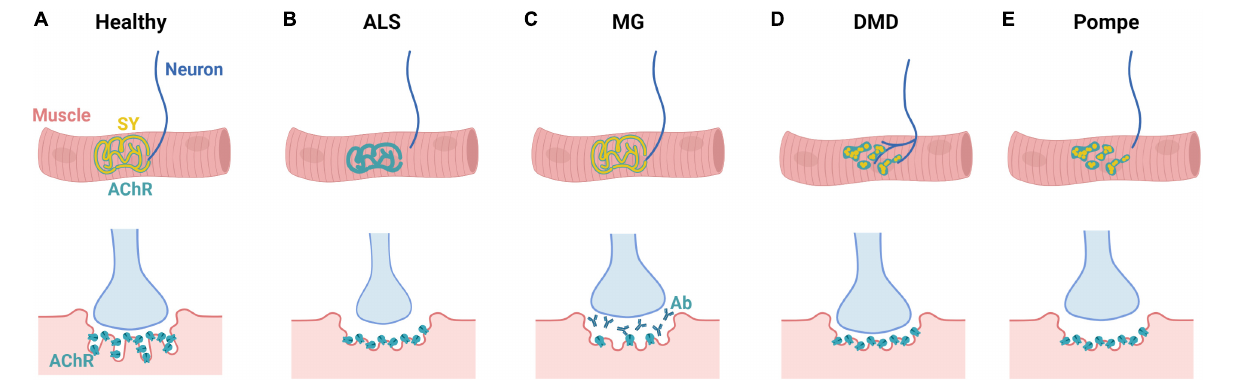
FIGURE 5 | NMD-specific changes in NMJ morphology. (A) Mature human NMJs present with a characteristic “pretzel” shape and contain both synaptophysin (SY) and acetylcholine receptors (AChRs). NMJ endplates exhibit distinct membrane folds that extend into the muscle cell cytoplasm. (B) In ALS, marked decrease in synaptophysin and NMJ size occurs alongside denervation. Additionally, ALS patients present with smaller nerve terminals and flattened synaptic clefts. (C) In MG, NMJ morphology is generally maintained; however, there is synaptic accumulation of autoantibodies (Ab), decrease in AChRs, and shortening of synaptic clefts. (D) In DMD, there is marked axonal branching and NMJ fragmentation alongside shortening of the synaptic cleft. (E) In Pompe disease, there is denervation alongside NMJ fragmentation and increased rates of MN